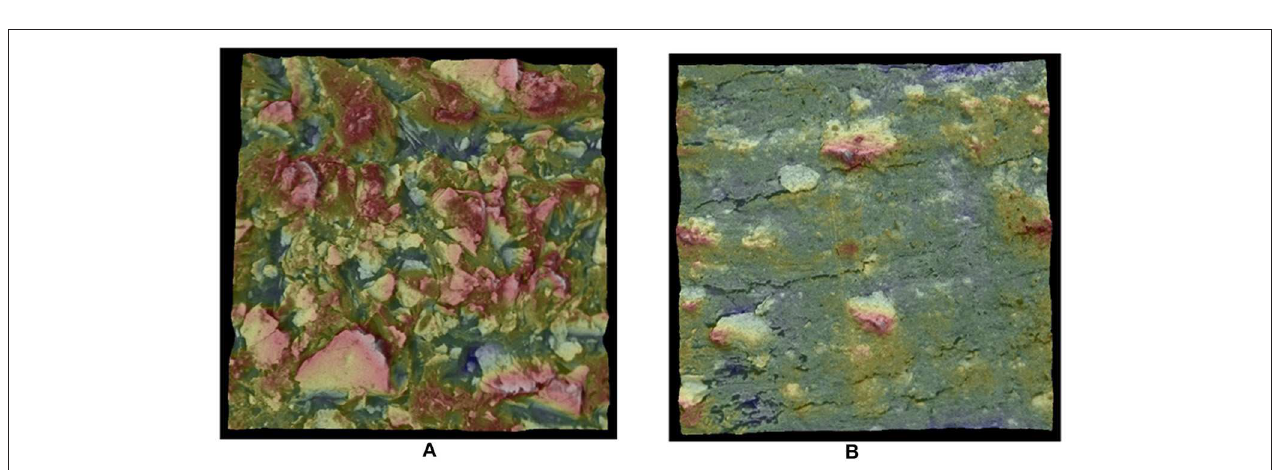
FIGURE 10 | SEM topographical images of the etched surface of (A) the undrawn Cu-filled PLA filament and (B) the filament drawn at 100 ◦ C and DR = 5.5.